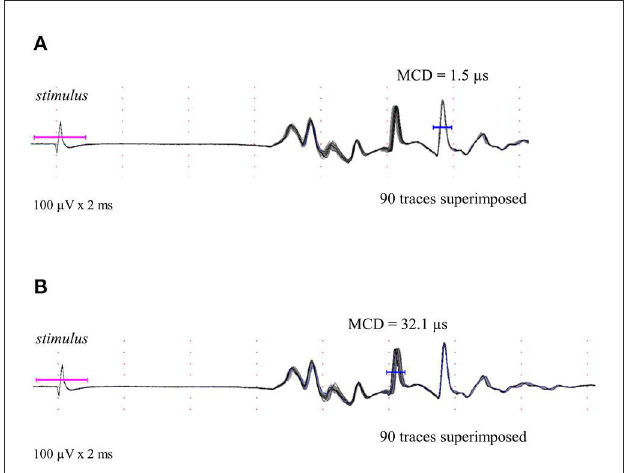
FIGURE5 Polyphasic complex of some muscle fiber action potentials after stimulation is shown as described in methods. Different muscle fiber action potentials could be obtained by direct and indirect stimulation. (A) Typical direct stimulated muscle fiber action potential is shown and confirmed by the mean consecutive difference superimposed (90 traces and 1.5 µ s). (B) Typical indirect stimulated muscle fiber action potential (neuromuscular jitter) is shown and confirmed by the mean consecutive difference superimposed (90 traces and 32.1 µ s).